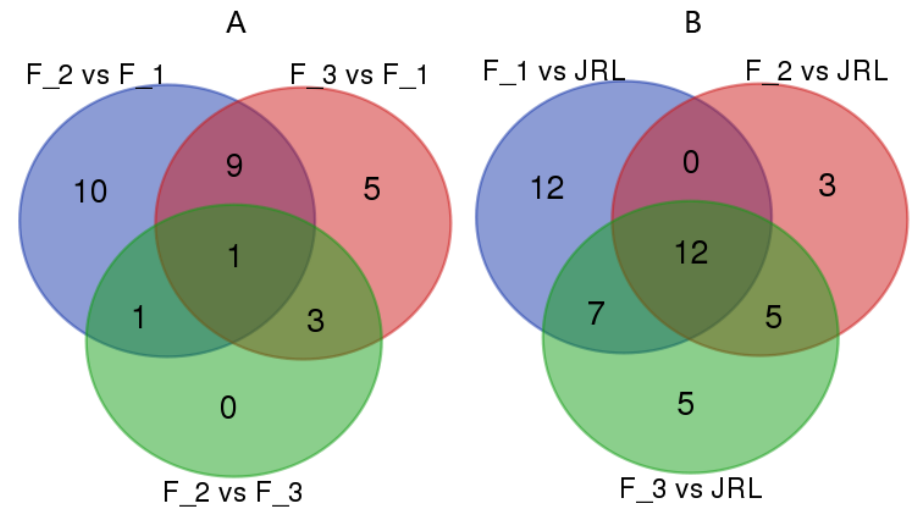
Figure 3. Venn diagrams of the differentially expressed miRNAs in the four libraries. ( A ) Differentially expressed miRNAs in flower buds at different stages of differentiation. ( B ) Differentially expressed miRNAs between flower buds and leaf buds. F_1, female flower buds before flower induction; F_2, female flower buds during flower induction; F_3, female flower buds after flower induction; JRL, leaf buds during flower induction.